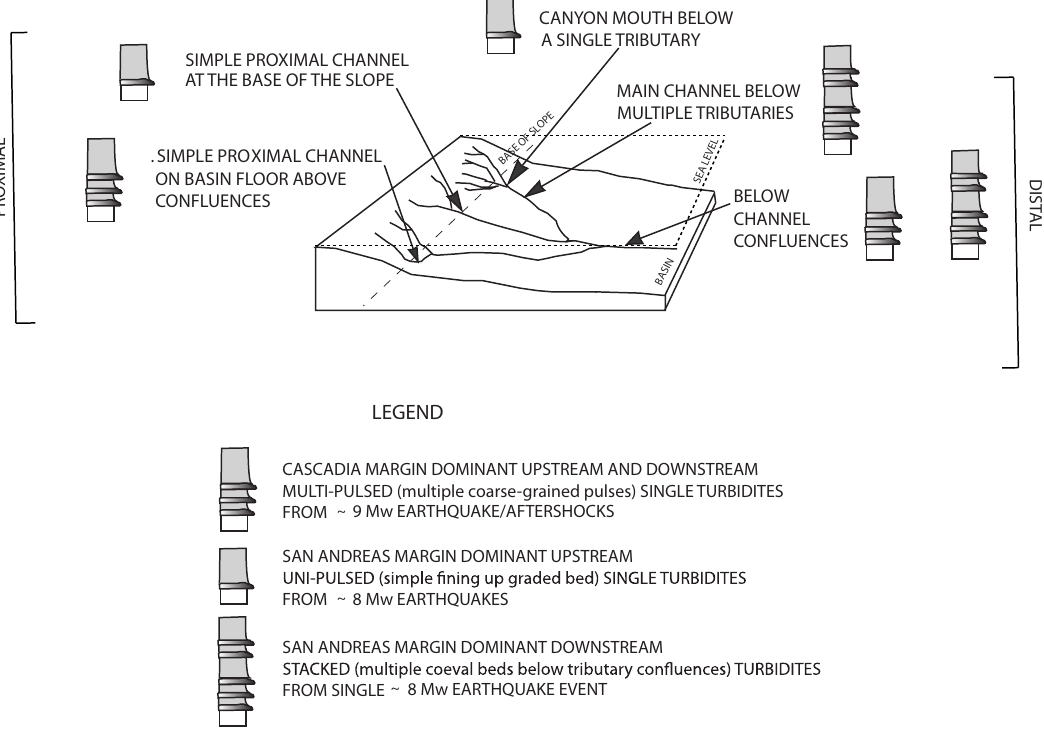
Fig. 10. Morphologic model for seismo-turbidite deposition in the active tectonic margins of western North America. Uni-pulsed, multi- pulsed or stacked turbidites are correlated with each type of canyon or channel morphologic setting and earthquake magnitude. (Figure modified from Guti´errez Pastor et al.,